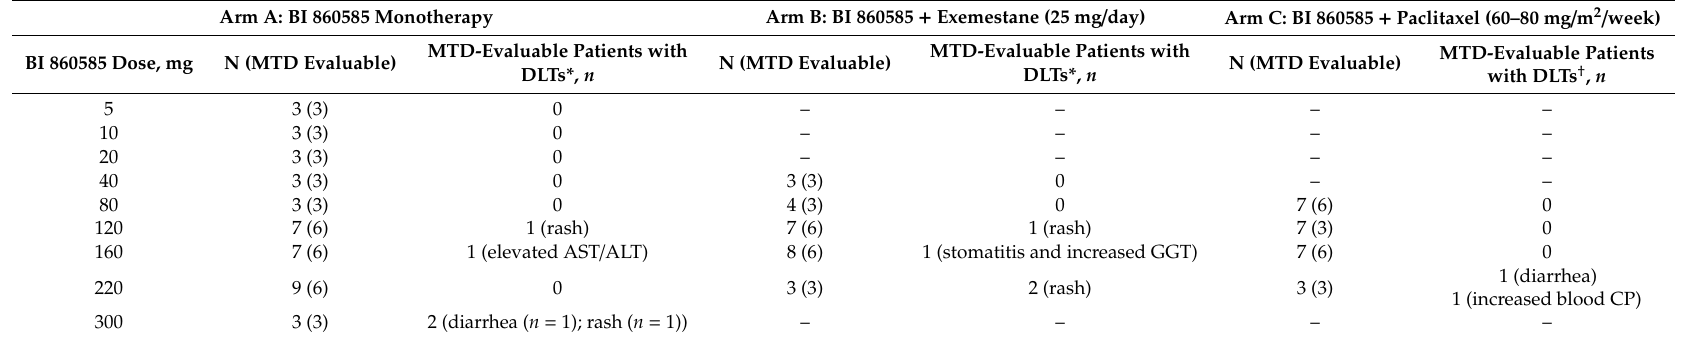
Table 2. Dose-limiting toxicity (DLT) in cycle